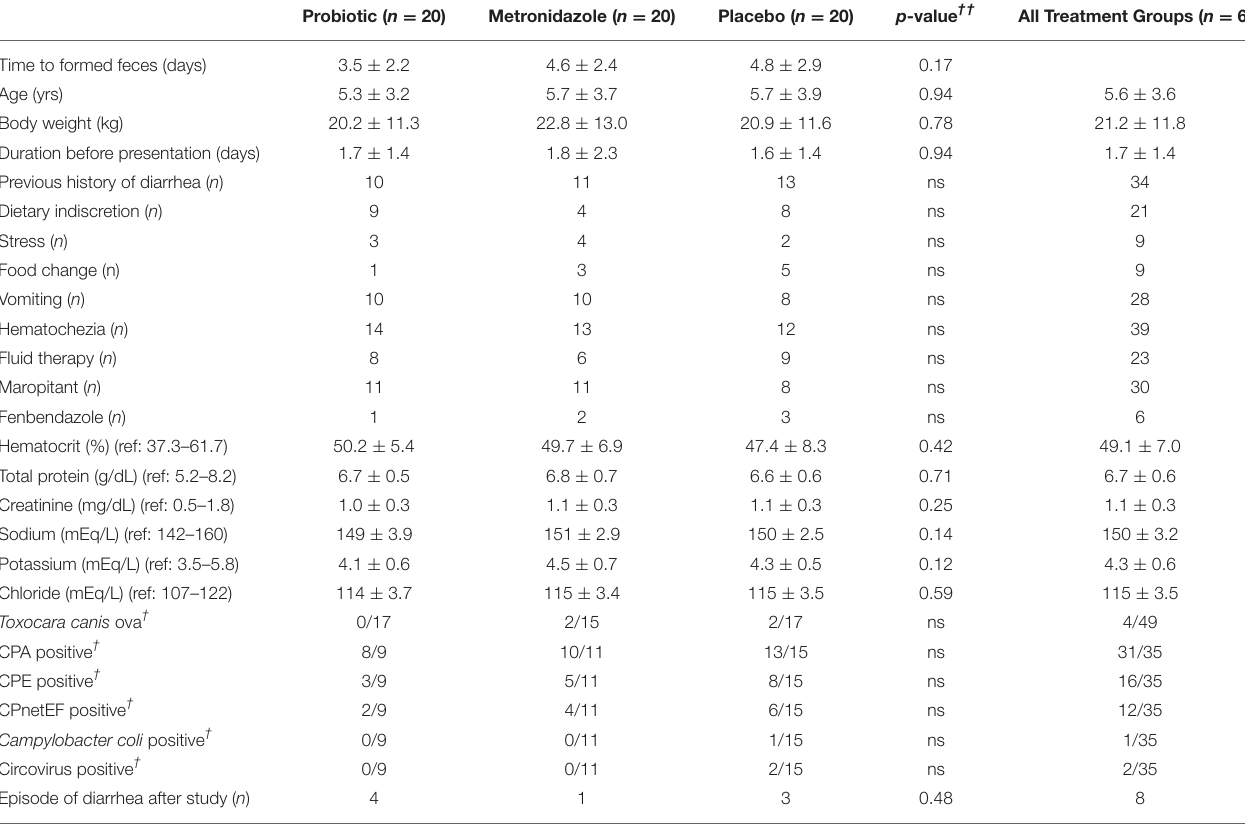
TABLE 1 | Comparison of patient characteristics, history, additional treatments, laboratory testing, and time to formed feces between study treatment groups. Probiotic ( n = 20) Metronidazole ( n = 20) Placebo ( n = 20) p -value †† All Treatment Groups ( n = 60) Time to formed feces